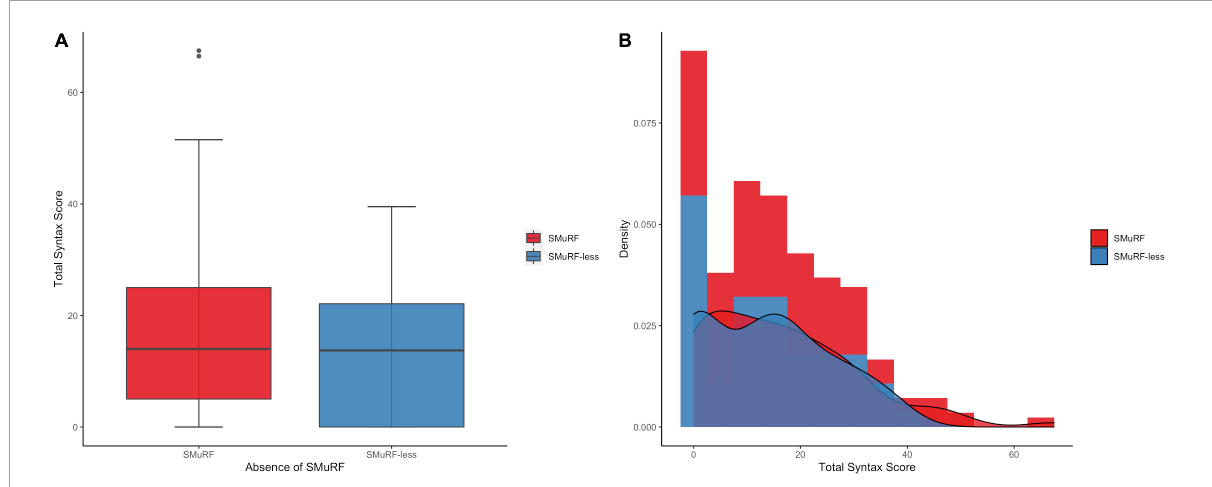
FIGURE1 SYNTAX score distribution by the presence of SMuRFs. (A) The boxplots depict almost equal median SYNTAX score among patients with and without SMuRFs. (B) The histogram indicates the higher proportion of zero SYNTAX score in SMuRF-less patients. SMuRF, standard modifiable risk